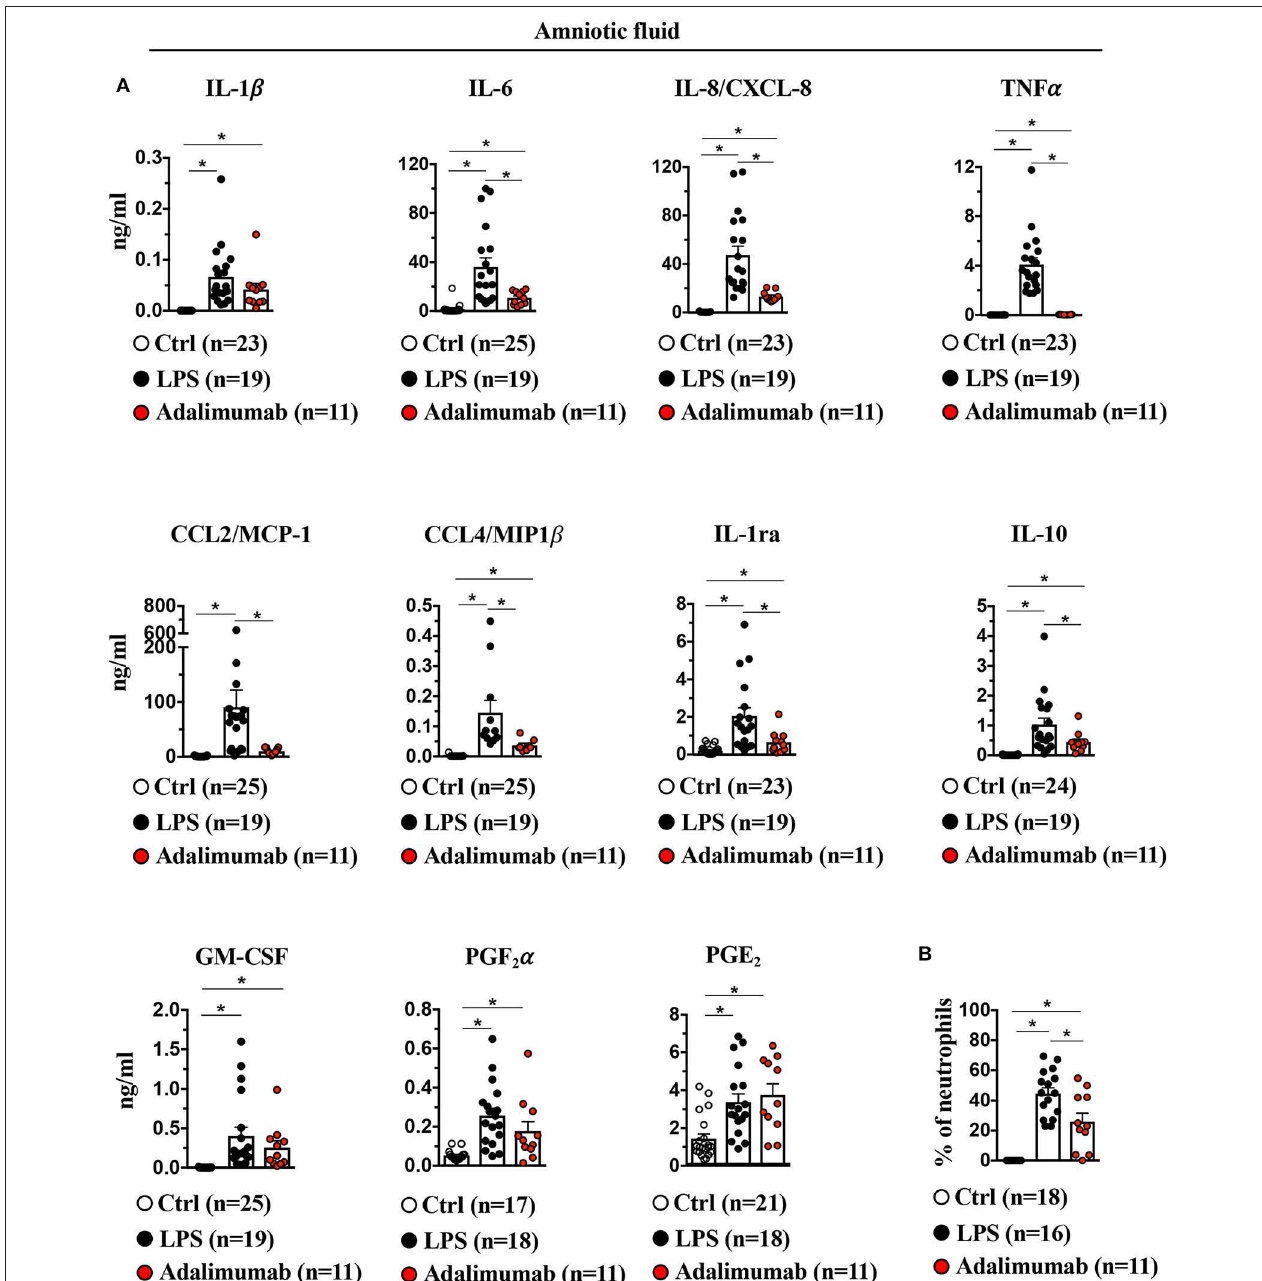
FIGURE 7 | Adalimumab decreased intrauterine inflammation in amniotic fluid. (A) Cytokine and prostaglandins concentrations were measured in amniotic fluid by multiplex ELISA. IL-1 β , IL-6, IL-8/CXCL8, TNF α , CCL2/MCP1, CCL4/MIP1 β , IL-1ra, IL-10, but not GM-CSF, PGF2 α and PGE2 were significantly decreased upon Adalimumab treatment. (B) Adalimumab decreased frequency of neutrophils in amniotic fluid. Data are mean ± SEM, * p < 0.05 vs. controls (Ctrl n = 17–25; LPS n = 16–19; Adalimumab n = 11; Mann–Whitney U